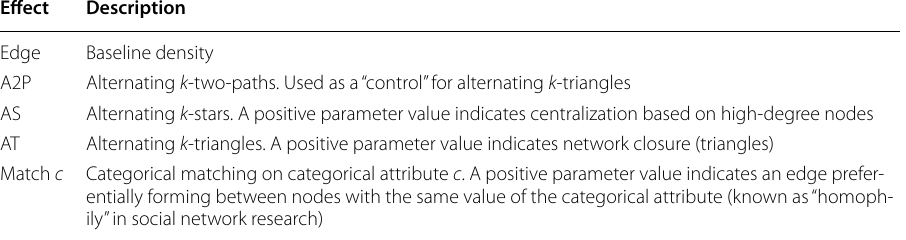
Table 2 Parameters for undirected networks